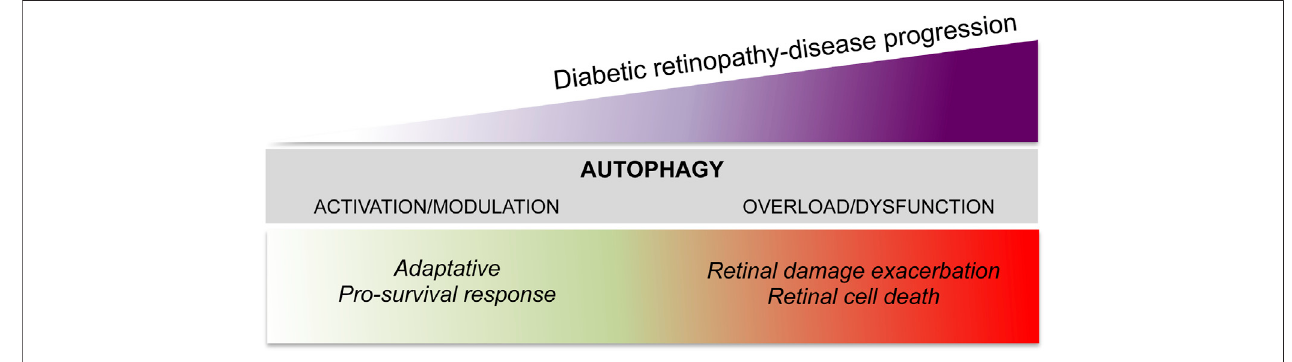
FIGURE 2 | The dual role of autophagy in diabetic